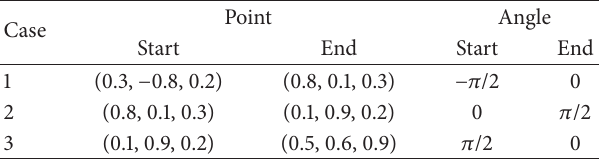
Table 3: The start and end configuration of the experiment